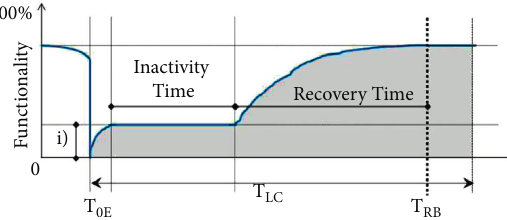
Figure 3: Conceptual seismic resilience measurement of whole communities